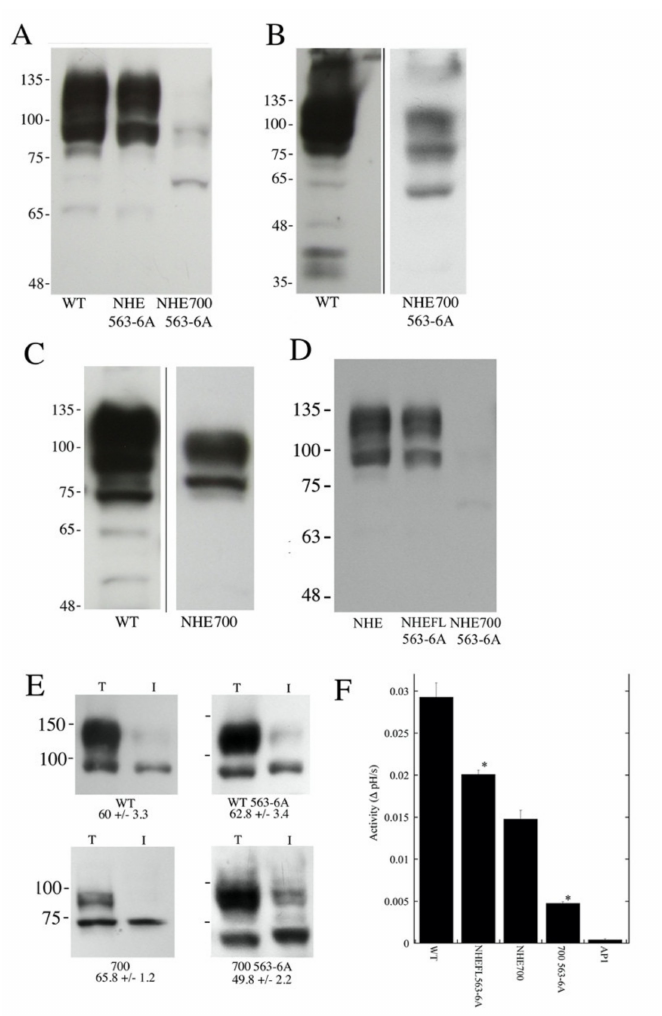
Figure 5. E ff ect of mutation of amino acids 563–566 on NHE1 with extended carboxyl terminal tails. WT, wild type NHE1, NHE-563-6A (full length wild type NHE1 with amino acids 563–566 changed to Ala), NHE-700 (NHE1 shortened and terminated at amino acid 700), NHE1 shortened to amino acid 700, 700 563-6A, NHE1 shortened to amino acid 700 and with amino acids 563–566 changed to Ala, AP1, and cells with no Na + / H + exchanger. ( A ) Western blot of cell lysates from wild type (WT) NHE1-containing cells, wild type full-length NHE1 with amino acids 563–566 changed to Ala (NHE FL-563-6A), and NHE1 shortened to amino acid 700 and with amino acids 563–566 changed to Ala (NHE-700-563-6A). ( B ) Long exposure of Western blot of NHE1 from wild type (WT)-containing cells and cells containing NHE-700-563-6A. ( C ) Long exposure of the Western blot of NHE1 from wild type (WT)-containing cells and cells containing NHE-700. ( D ) Comparison of levels of NHE1 and NHE1 with the mutation of 563–566 to Ala. Equal amounts of cell lysates that contained each type of NHE1 were loaded onto gels and immunoblotted with anti-HA antibodies. ( E ) Surface processing of wild type (WT) NHE1-containing cells, NHE1 with amino acids 563–566 changed to Ala (NHE-FL-563-6A), as well as NHE1 shortened to amino acid 700 along with amino acids 563–566 changed to Ala (700 563-6A). Numbers indicate the percent of proteins that were targeted to the cell surface. Results are the mean ± S.E. of at least 3 experiments. ( F ) Activity of wild type NHE1 and mutants. Cells that contained wild type or mutant proteins were acidified with ammonium chloride, as described in the Materials and Methods sections. The initial rate of recovery was measured and recorded as ∆ pH / s. n > 8. * p < 0.001 compared with equivalent length protein without 563–566 to Ala